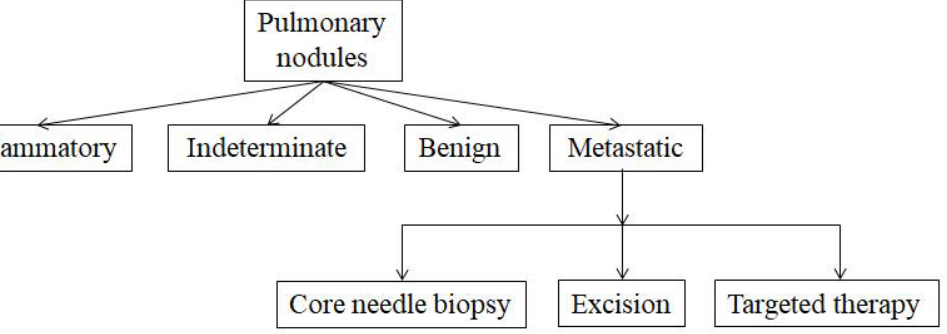
Figure 3. Classification and management pattern after MDT discussion of pulmonary nodules.